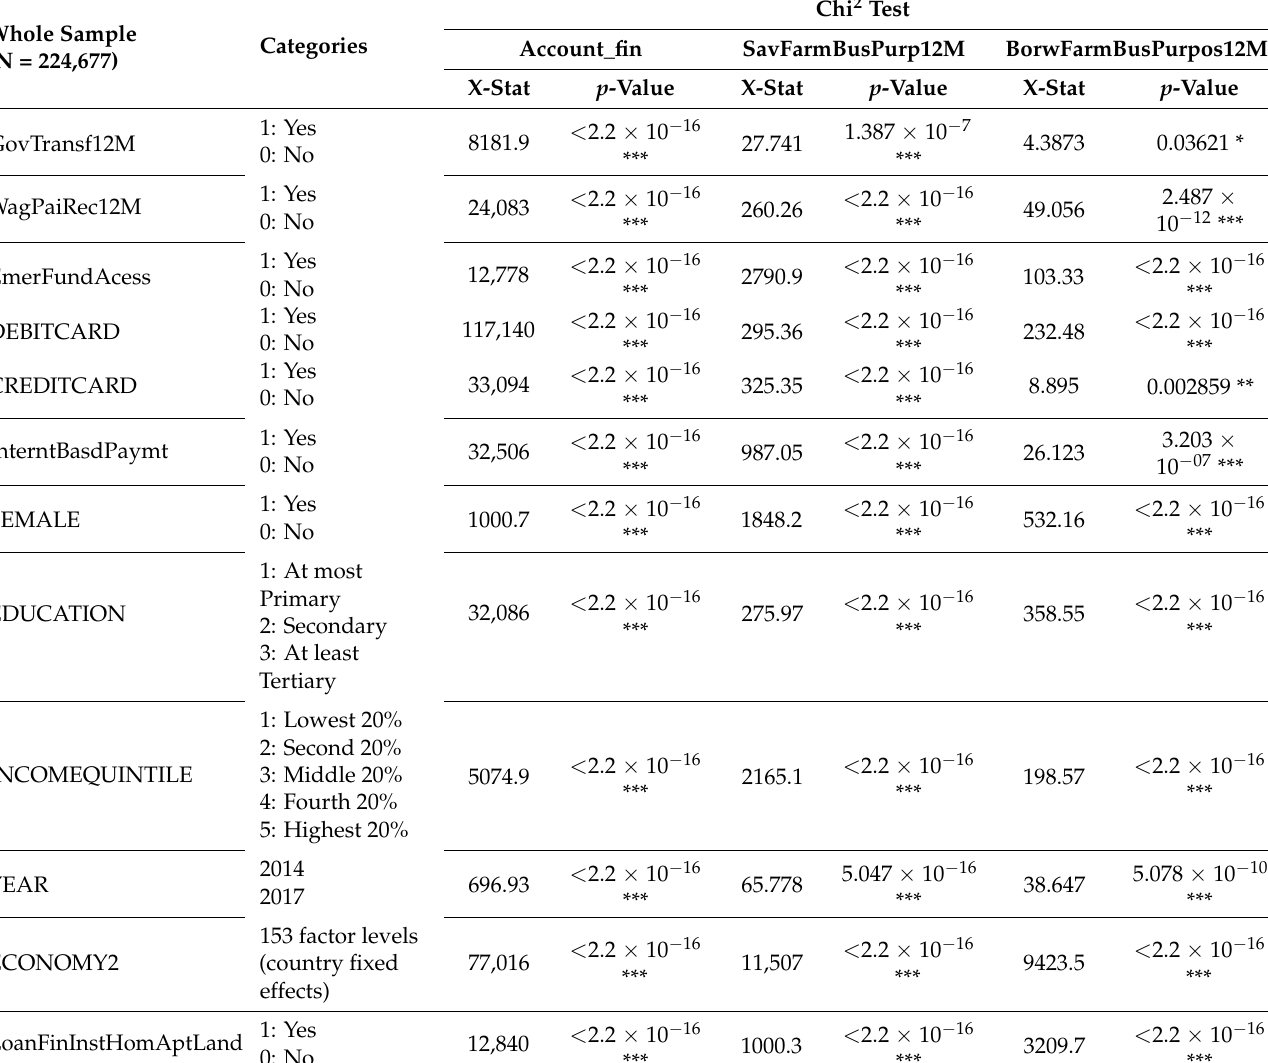
Table A3. Chi-square test of Independence between the nominal predictors and formal account ownership, Entrepreneurial saving and Entrepreneurial borrowing over the previous 12